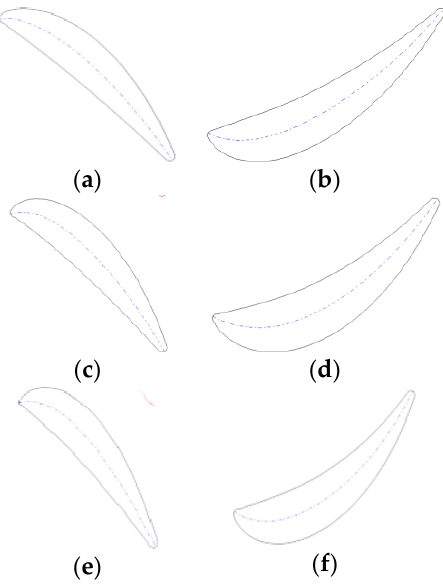
Figure 2. Profiles of blades: ( a ) 1st stator; ( b ) 1st rotor; ( c ) 2nd stator; ( d ) 2nd rotor; ( e ) 3rd stator; ( f ) 3rd rotor.